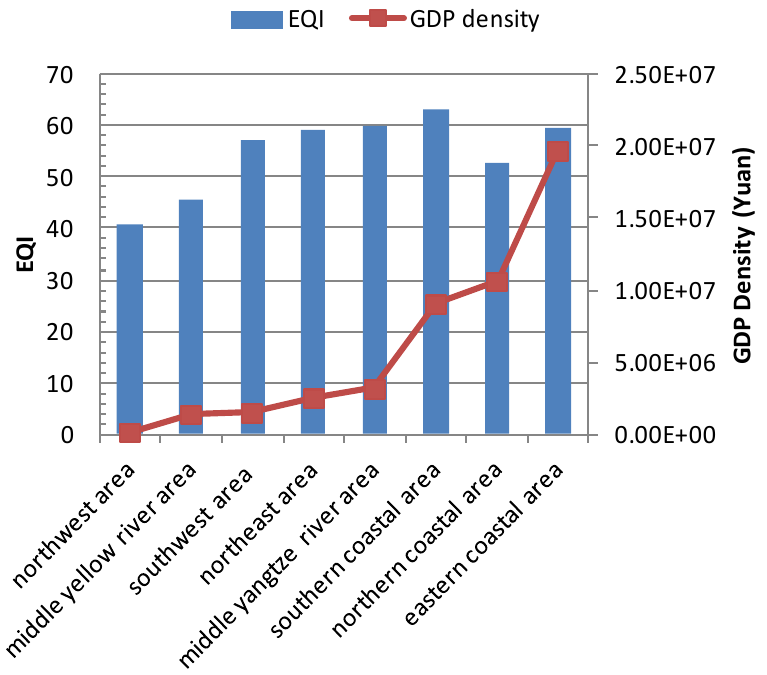
Figure 13. Relationship between EQI and GDP density in eight economic regions in